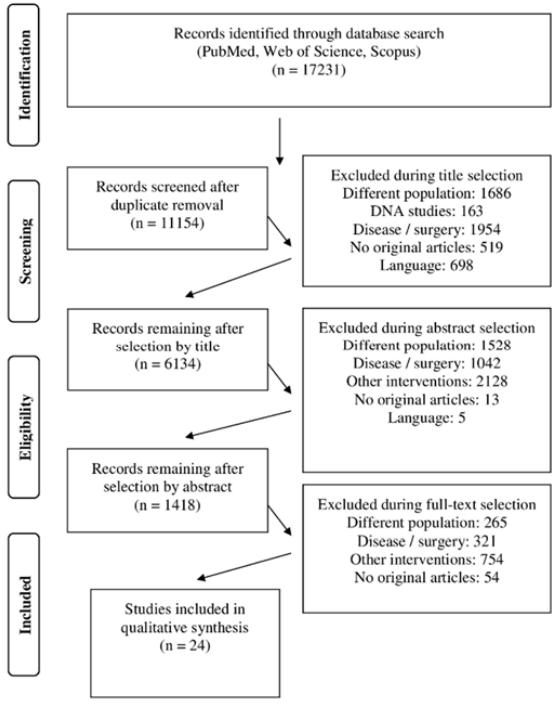
Figure 1. Flow chart of the study collection process. A total of 1222 (age range 20–70) participants, 748 of them with OA, have been included. The mean age was 47 (18), 542 were females, 380 were males; for 300, the gender was not specified. The main study characteristics are summarized in Table 1.